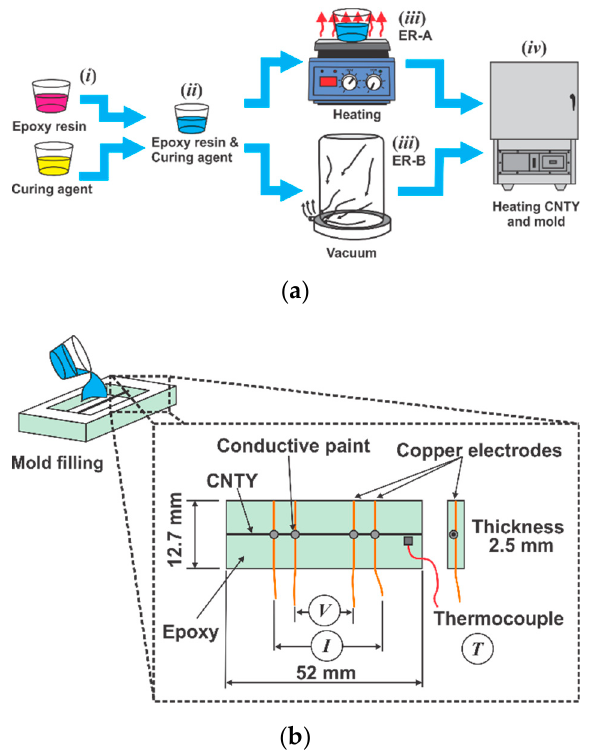
Figure 1. Manufacturing and in situ electrical measurements of carbon nanotube yarns (CNTY)/epoxy specimens. ( a ) Sequential steps for specimen manufacturing (mold filling), ( b ) in-situ electrical measurements and dimensions of CNTY/epoxy specimens. Steps related to heating are not used for epoxy resin (ER)-B-RT and ER-B-50.